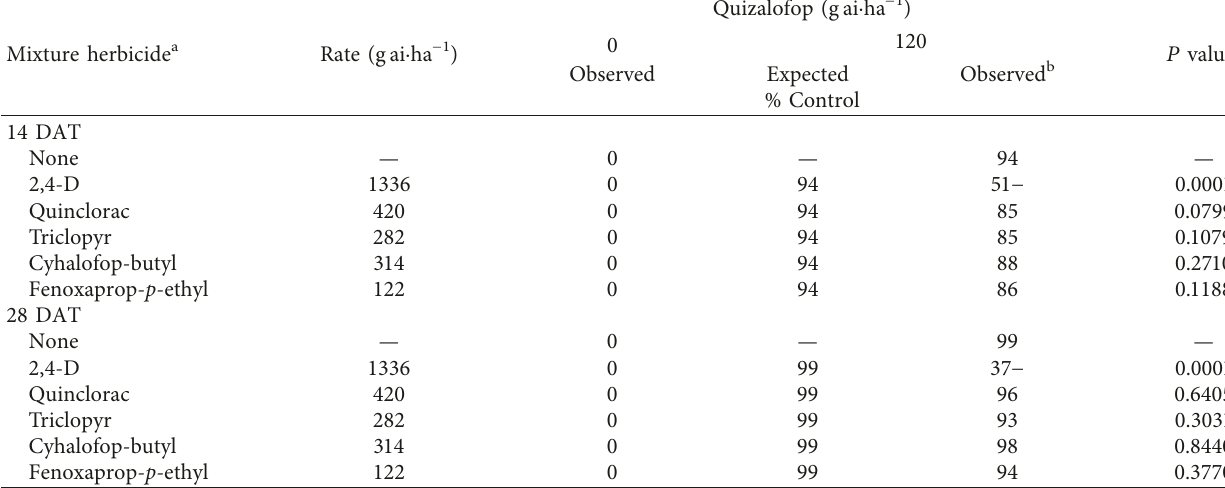
Table 3: Red rice control with quizalofop- p -ethyl mixed with different synthetic auxin or ACCase-inhibiting herbicides in 2015 and 2016 crop seasons.